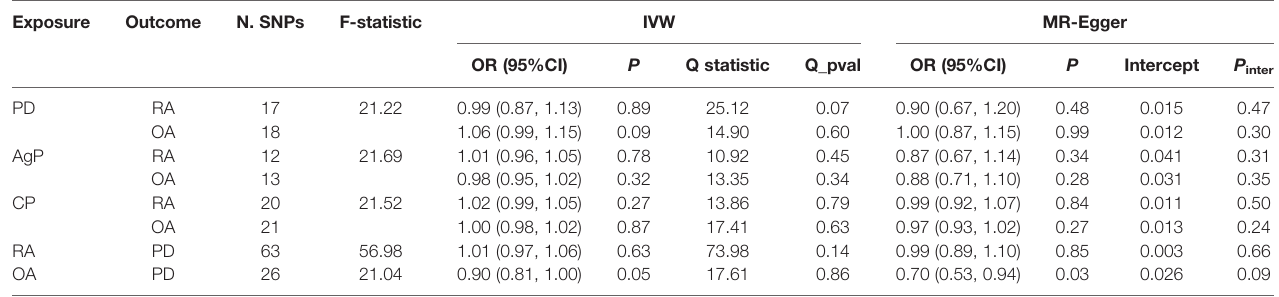
TABLE 1 | MR estimates of assessing the causal association between PD and arthritis.. Exposure Outcome N. SNPs